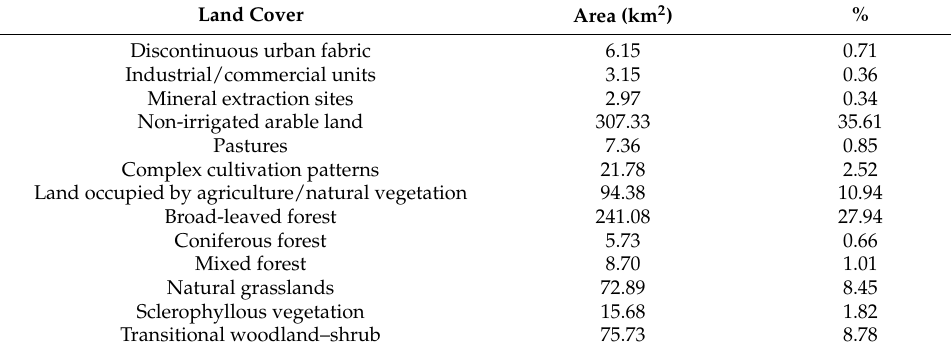
Table 1. Florina hydrological basin land cover (CORINE